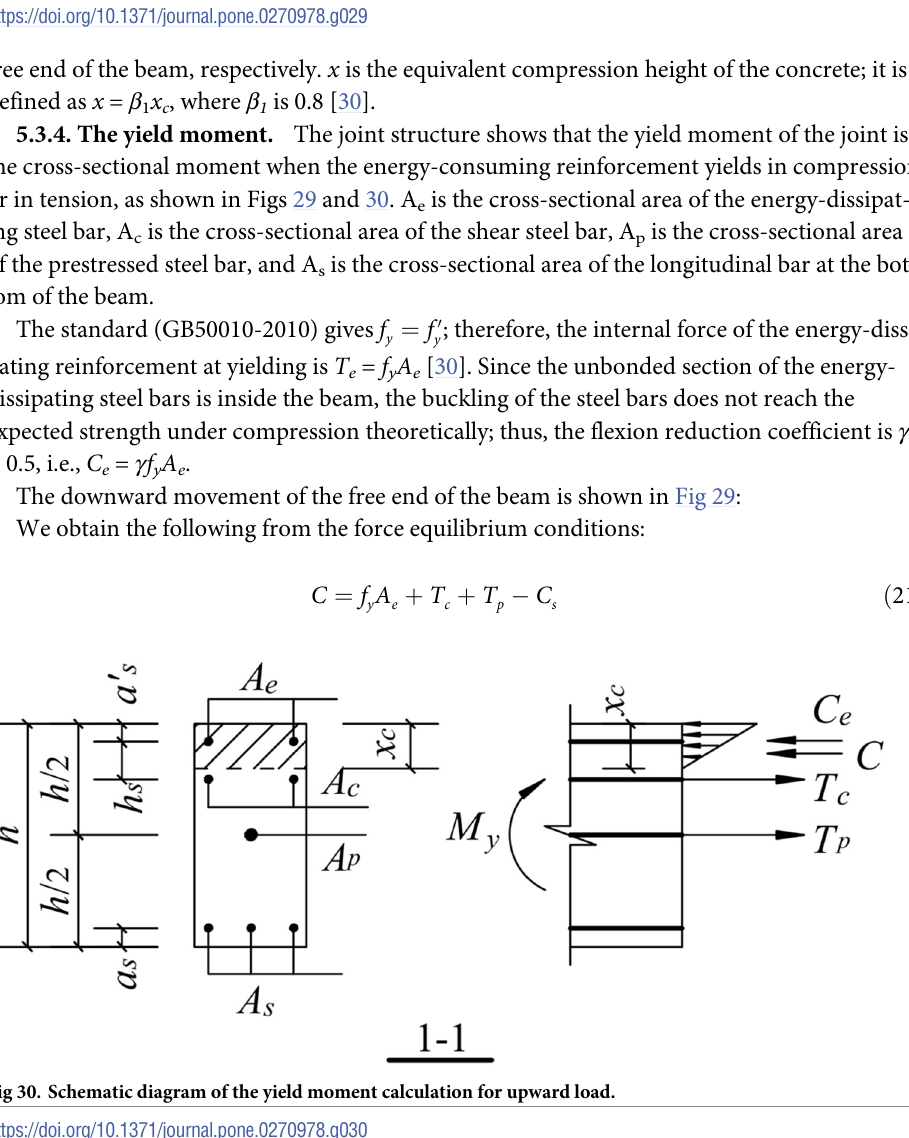
Fig 29. Schematic diagram of the yield moment calculation for downward load.